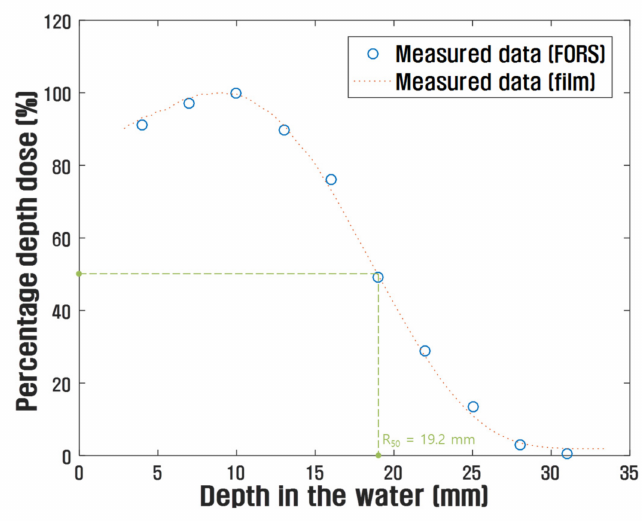
Figure 7. Measured PDDs using the FORS and the